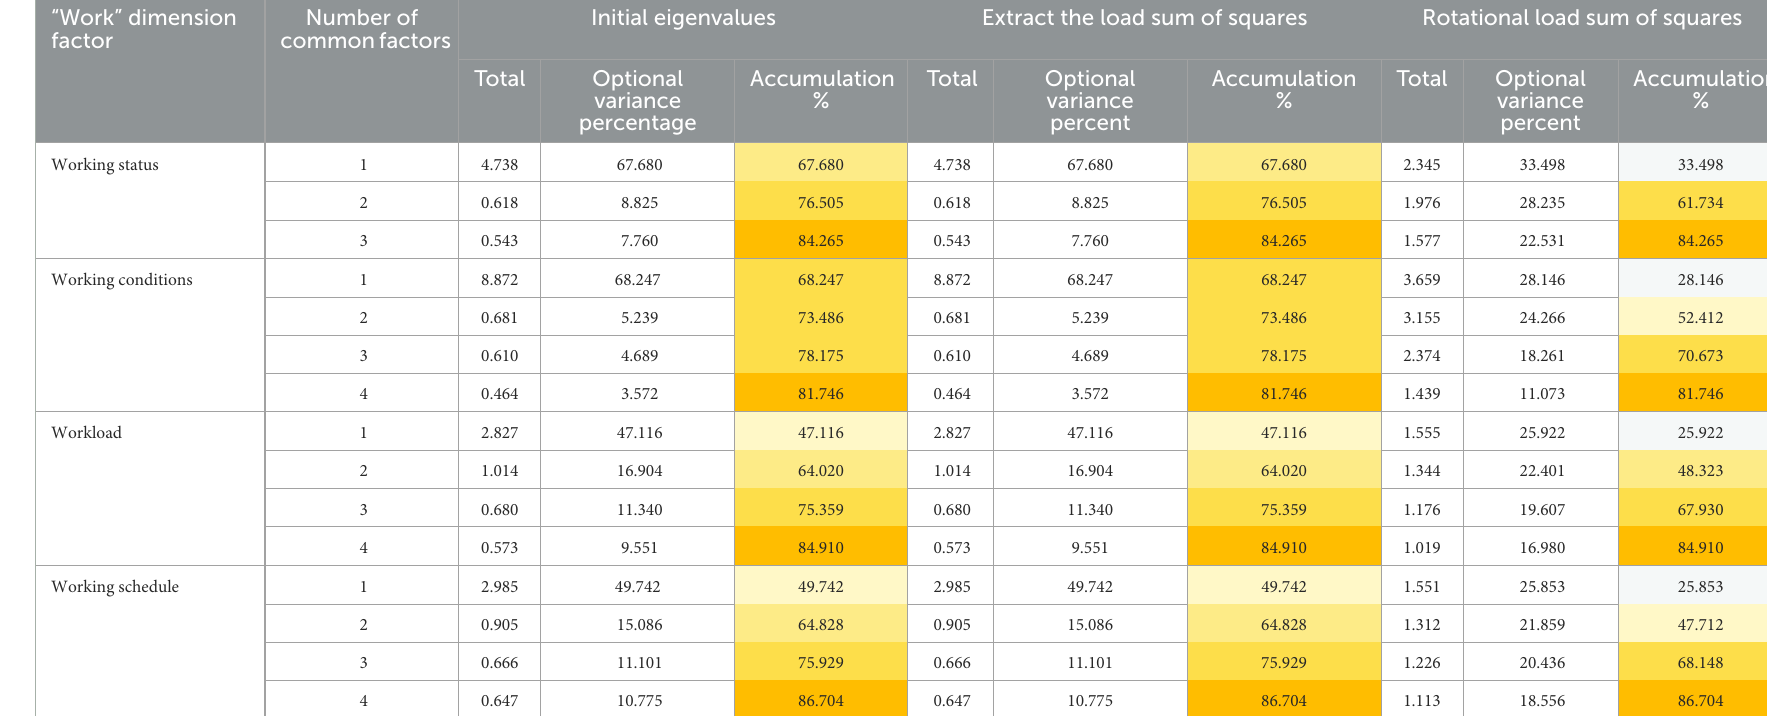
TABLE 3 Evaluation parameters when extracting common factors for fatigue influencing factors of the “work” dimension ∗